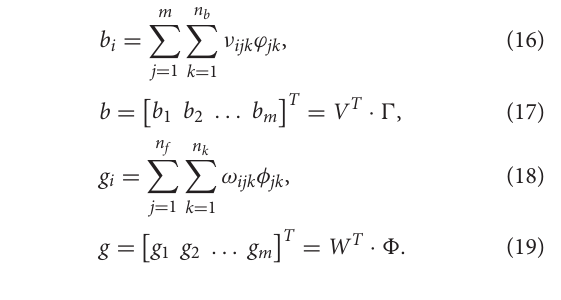
6. Output Space U : The output of the proposed iFBEL is the combination of the outputs of the BEL and the FNN, in which the BEL works as a primary controller and the FNN as an emotion controller: